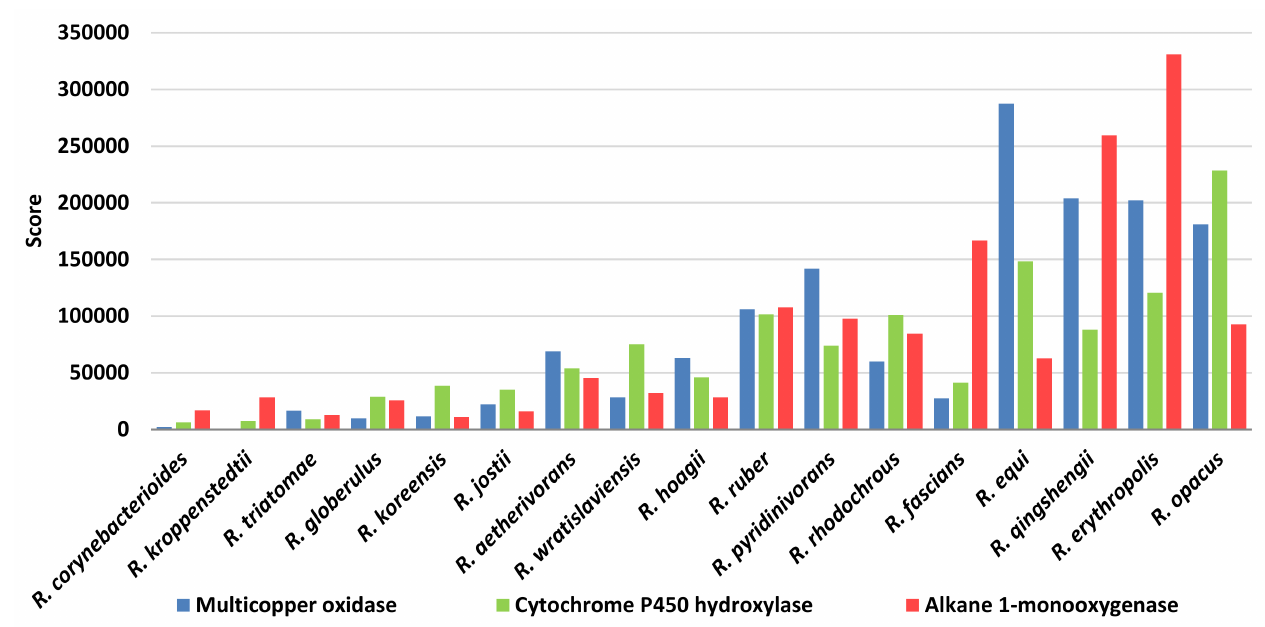
Figure 14. Score values for the most prominent Rhodococcus species for the main enzymatic categories involved in C-C backbone plastic degradation.